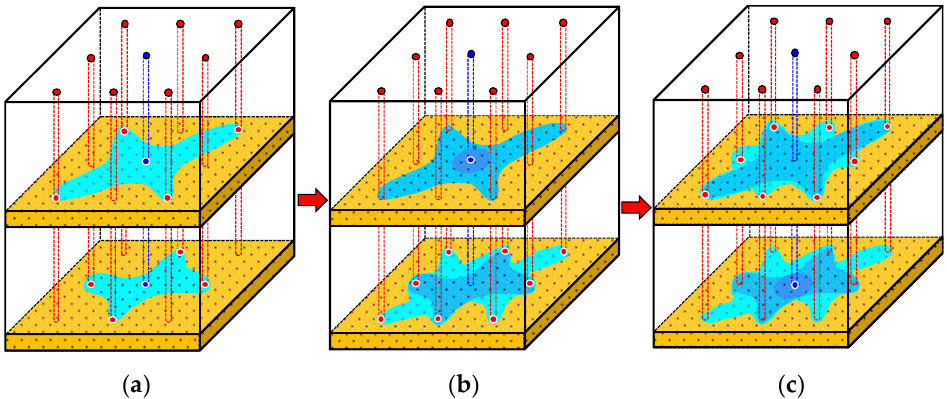
Figure 1. Schematic diagram of multi-layer cyclic alternate injection and production. ( a ) There are currently two development layers; ( b ) first half period of cyclic alternate injection and production; ( c ) second half period of cyclic alternate injection and production.